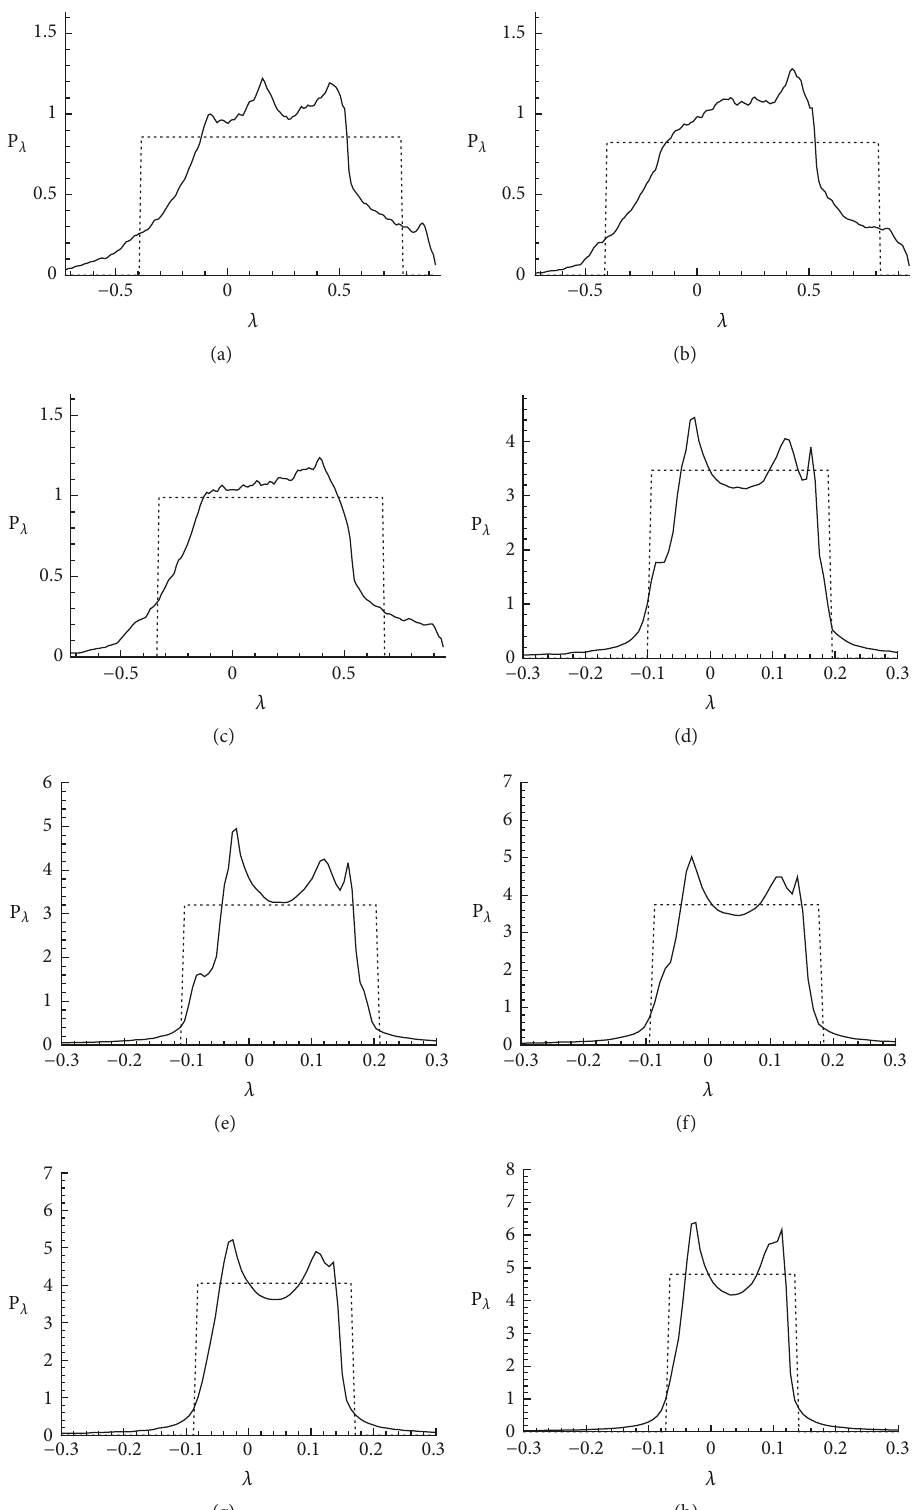
̃ 𝜆 Figure 2: Distribution function of for | 𝜉 | = 10 −3 . (a) 𝑞 = 2.75 , (b) 𝑞 = 3.75 , (c) 𝑞 = 4.5 , (d) 𝑞 = 17 , (e) 𝑞 = 17.5 , (f) 𝑞 = 19.25 , (g) 𝑞 = 20.75 , and (h) 𝑞 = 24